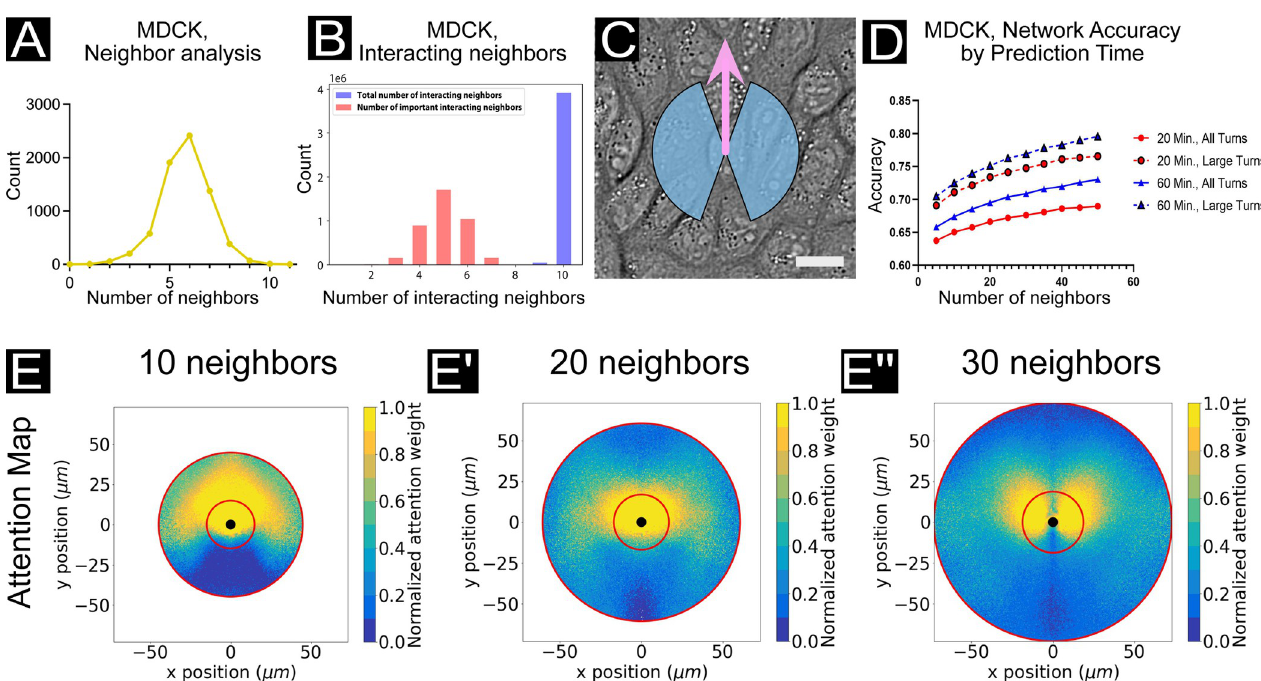
Fig 3. Local vs. long-range interactions in MDCK epithelia (bulk regime). (A) The number of nearest neighbors based on an analysis of 1165 cells using the ImageJ/FIJI [47] BioVoxxel plugin [48] (see Methods ). A peak can be observed at 6 nearest neighbors. (B) Histograms of total interacting cells (blue) and “important” interacting cells (red), as determined by a function utilizing the network aggregation weights ( W ) to estimate the most influential neighbors to learned focal cell dynamics. (C) A snapshot of MDCK cells with blue region indicating the extent of “large” turns ( ± 20–160˚) according to the focal cell trajectory, as indicated by the pink arrow. Scale bar represents 20 μ m. (D) Network accuracy plots as prediction time and number of input neighbors is varied. Solid lines reflect accuracy scores for all turning angles in the focal agent trajectory; dashed lines reflect only large turns ( ± 20–160˚, see C). Accuracy increases with both number of neighbors encompassed by the network and prediction time. Cell trajectory timesteps were fixed at 10 minutes. (E, E’, E”) Attention maps for networks encompassing 10 ( E ), 20 ( E’ ), and 30 ( E” ) neighbors. Plots shown here are analogous to Fig 2C’, with cell trajectory timestep of 10 minutes. As the number of neighbors taken into consideration by the network increases, a wider spatial range of interactions may be considered for forward motion prediction. With an increased range from which dynamic information can be directly captured from neighboring agents, we can observe shifts in learned relative influence of neighbors; for example, as longer-range neighbors provide richer information pertaining to dynamic shifts in the forward direction than immediate forward neighbors. See S9 Fig for the matching study in HUVEC endothelial cells .